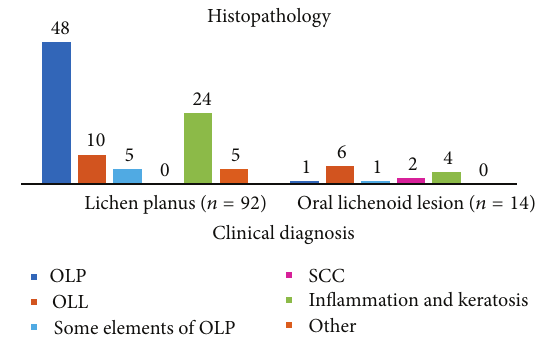
Figure 1: The distribution of clinical and histopathologic diagnoses amongpatients;OLP:orallichenplanus;OLL:orallichenoidlesions; OSCC: oral squamous cell